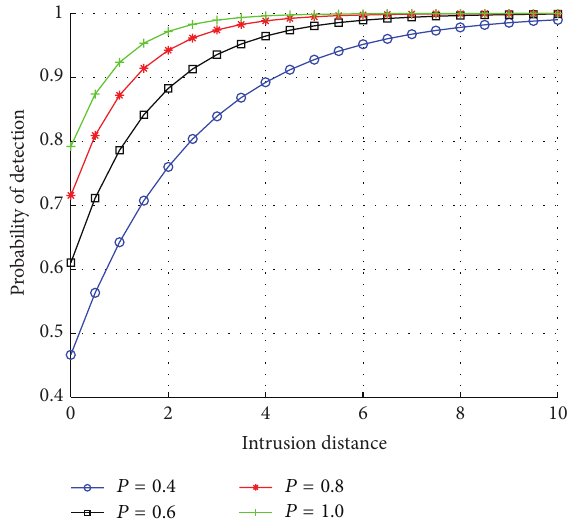
Figure 5: Intrusion detection probability as a function of the intrusion distance for different values of node